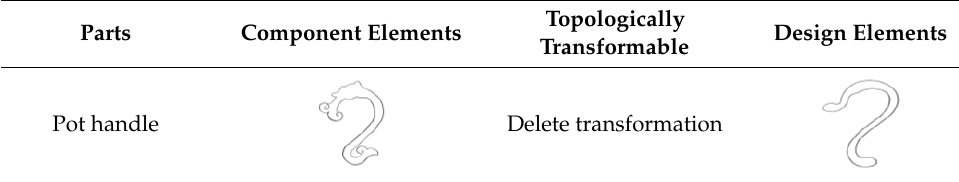
Table 5. Part handle deletion transformation.